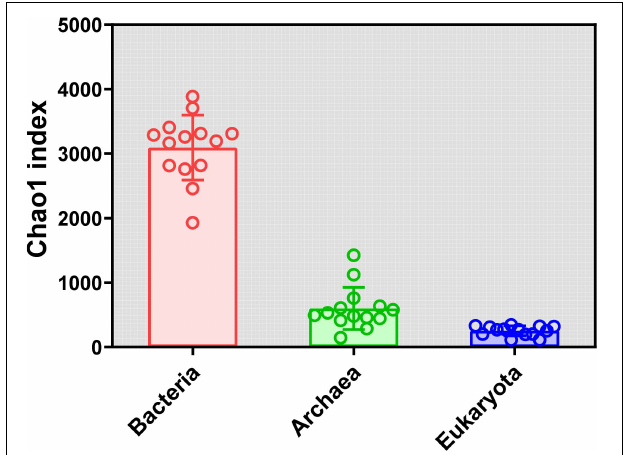
FIGURE 1 | α Diversity (Chao1 index) analysis for the soil microbial community in alpine meadows in the Qilian